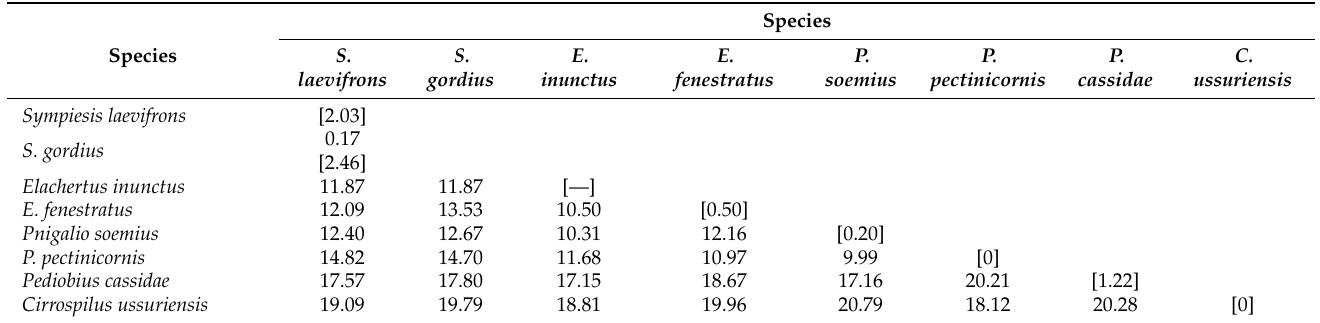
Table 1. Intra- and interspecific divergences in COI mtDNA gene among Eulophinae (Eulophidae) parasitoid species of Phyllonorycter issikii . Minimal pairwise distances are given for each species pair; values in square brackets represent maximal intraspecific distances; [—] no data because a single specimen was